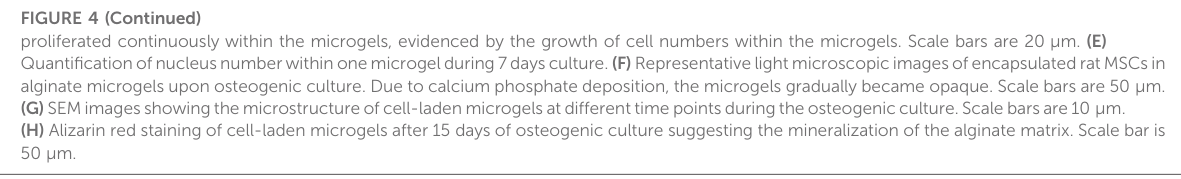
(G) SEMimagesshowingthemicrostructureofcell-ladenmicrogelsatdifferenttimepointsduringtheosteogenicculture.Scalebarsare10 μ m. (H) Alizarin red staining of cell-laden microgels after 15 days of osteogenic culture suggesting the mineralization of the alginate matrix. Scale bar is 50 μ